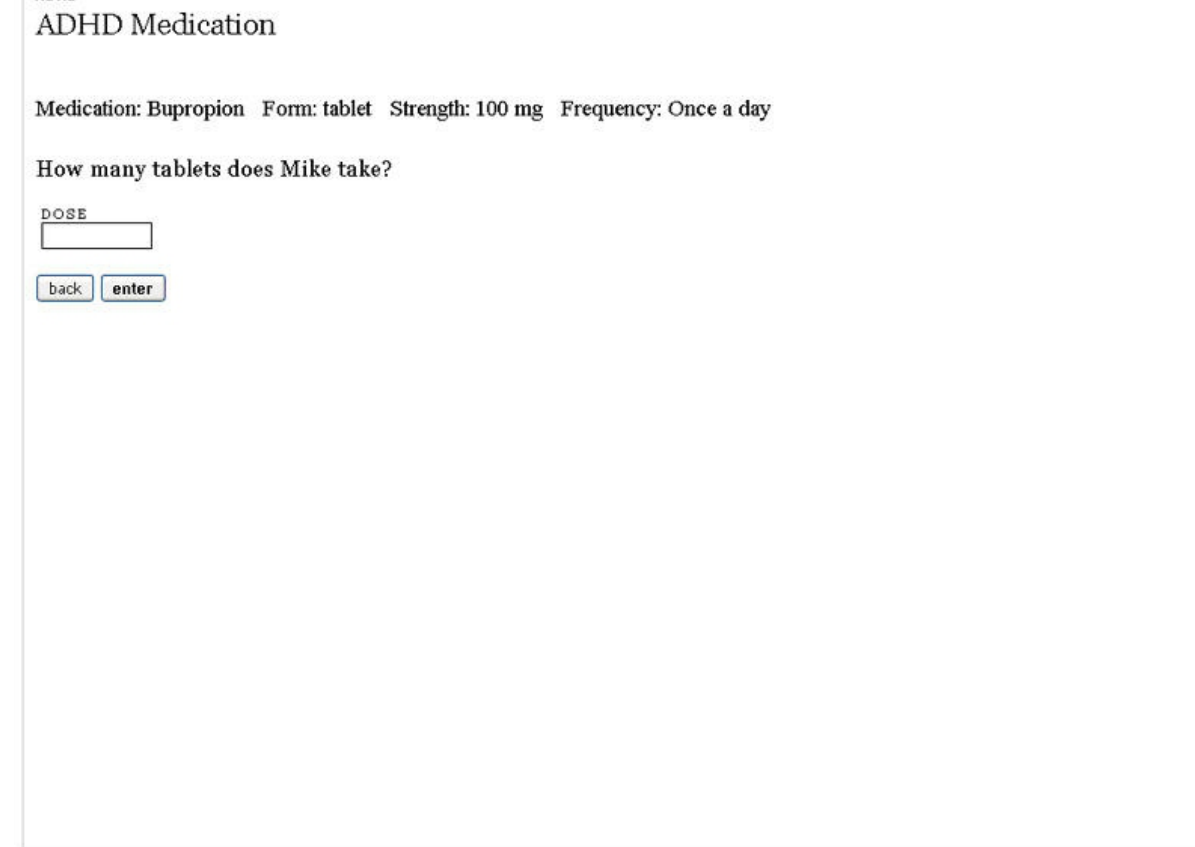
Figure 2. Screenshot from the medication module of the revised prototype used in the performance testing of the ADHD personal health